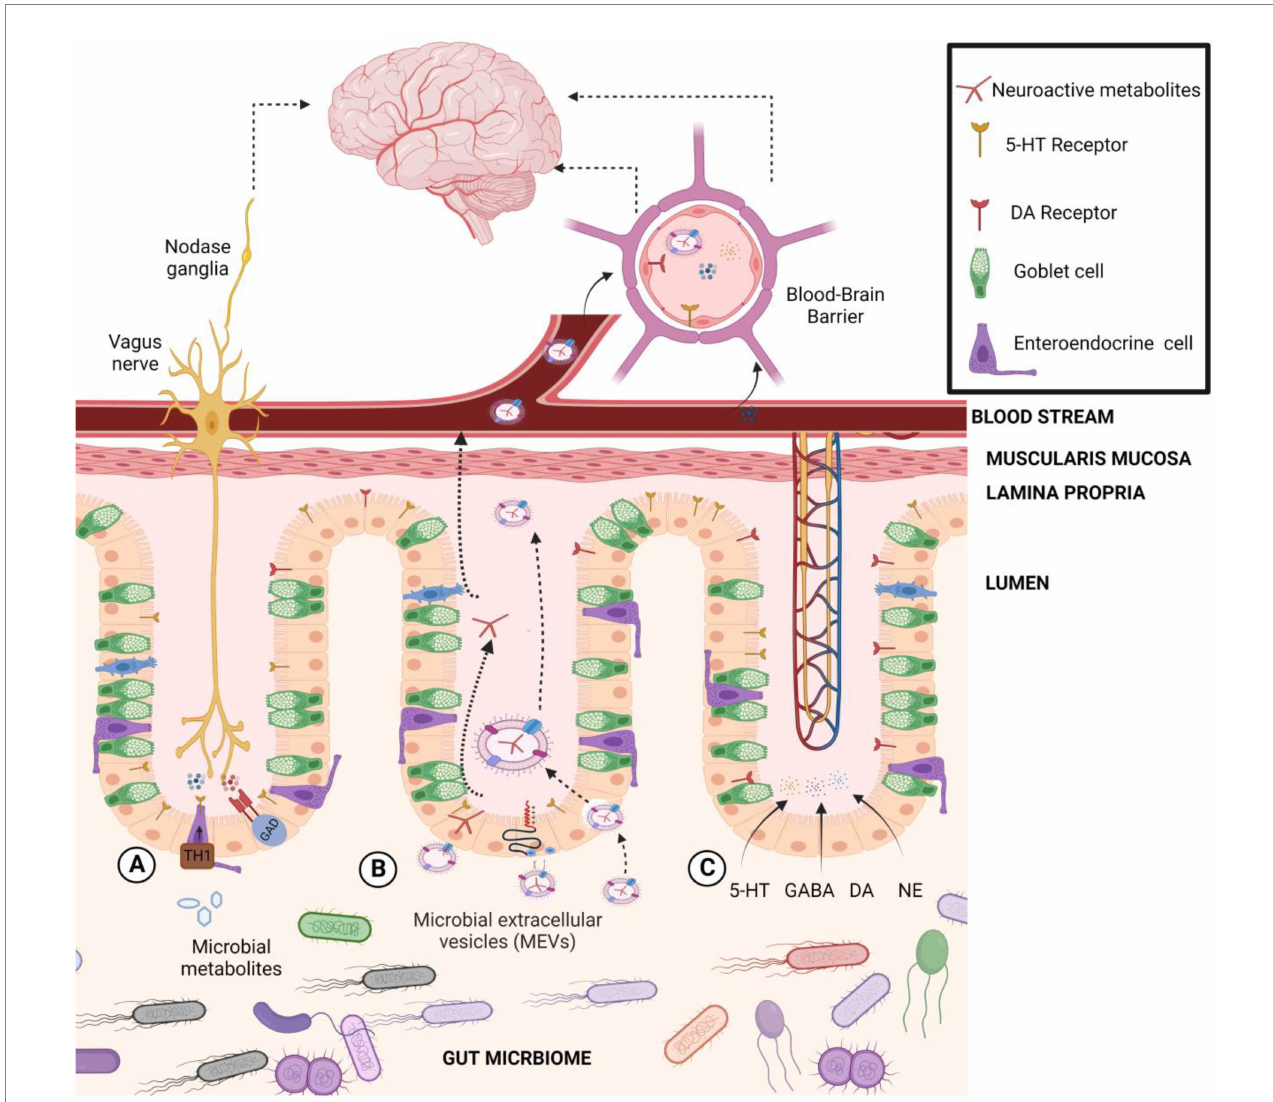
FIGURE 4 The transportation pathways of gut microbiota-derived neuroactive compounds to the brain. (A) Indirect transportation: gut microbiome regulates or induces host biosynthesis of neurotransmitters in cells like serotonin (5-HT) through tryptophan hydroxylase 1 (Tph1) or GABA through glutamate decarboxylase (GAD). (B) Microbial extracellular vesicle transportation: MEVs may bind to the cell receptor and deliver their contents to the host cell, activate a cell response, or be fully incorporated into the host cell’s cytoplasm. (C) Direct transport: Microbially modulated neurotransmitters could interact with receptors or circulate systemically to reach the blood–brain